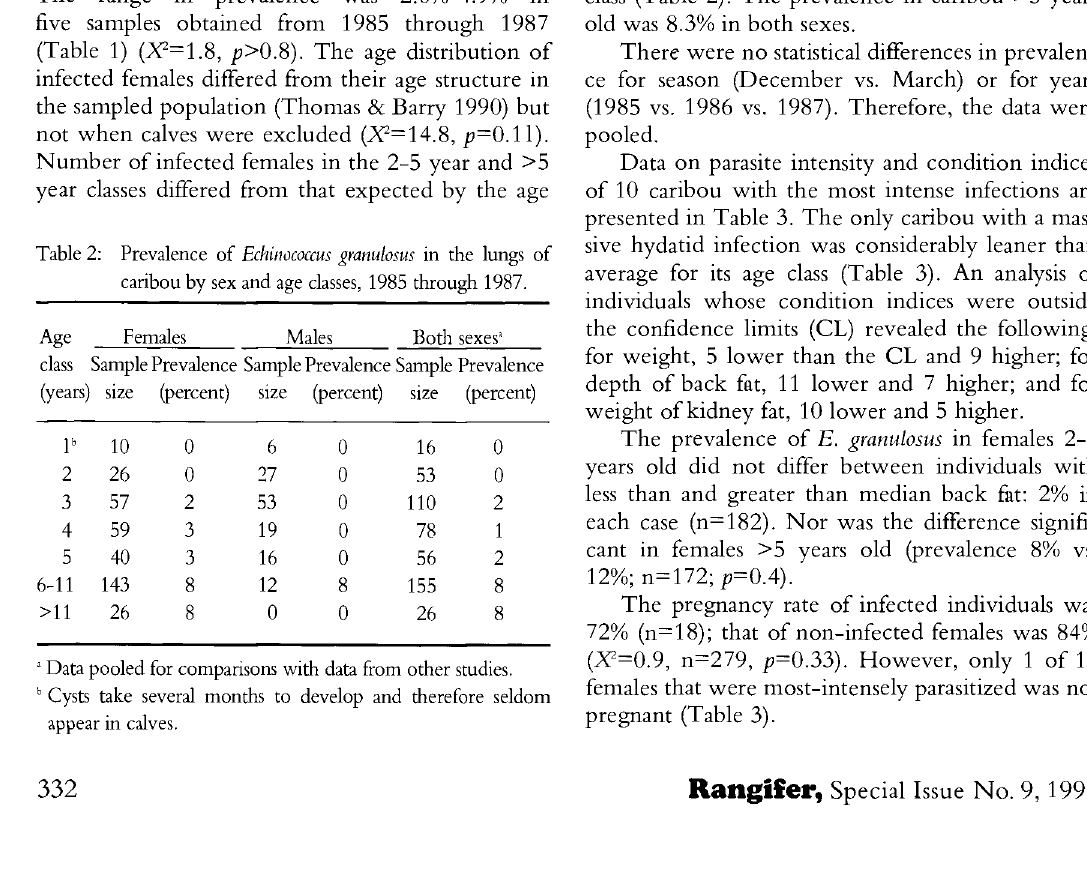
Table 2: Prevalence of Echinococcus granulosus in the lungs of caribou by sex and ai ge classes, 1985 through